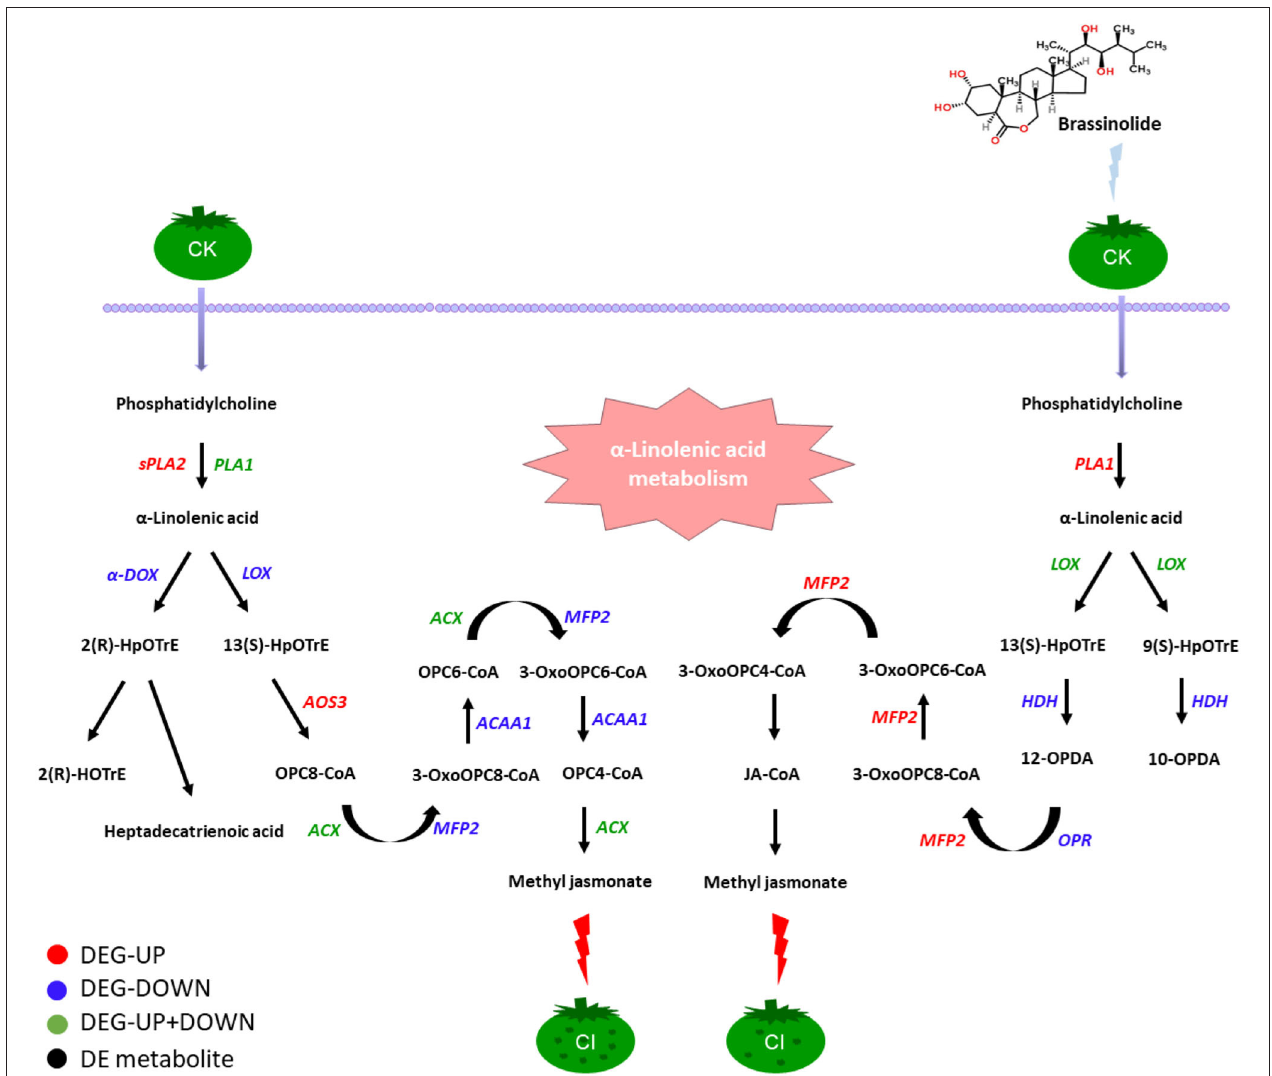
FIGURE 9 | Changes of genes and related enzymes involved in the CI process of tomato fruit under the regulation of BR. Among them, black fonts indicate differentially expressed metabolites, red fonts indicate that DEGs were upregulated, blue fonts indicate that DEGs were downregulated, and green fonts indicate that DEGs are both upregulated and downregulated and black fonts indicate those differential